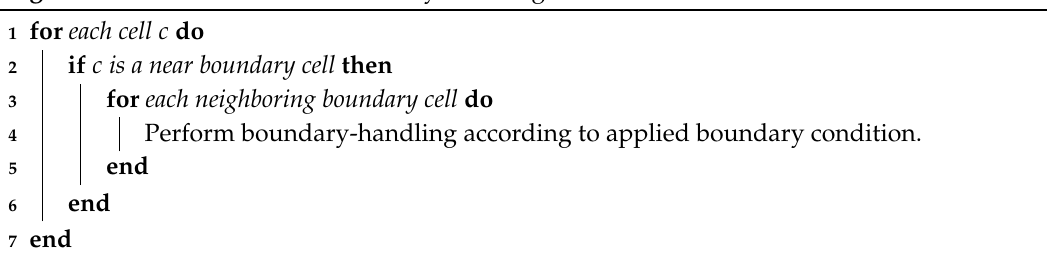
Algorithm 4: Pseudocode for boundary-handling.